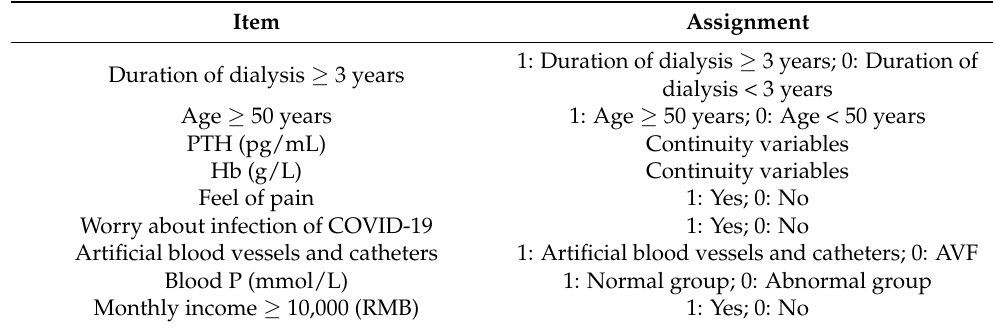
Table A1. The assignment of logistic regression.